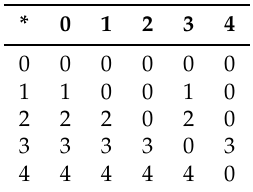
Table 5. Cayley table for the binary operation